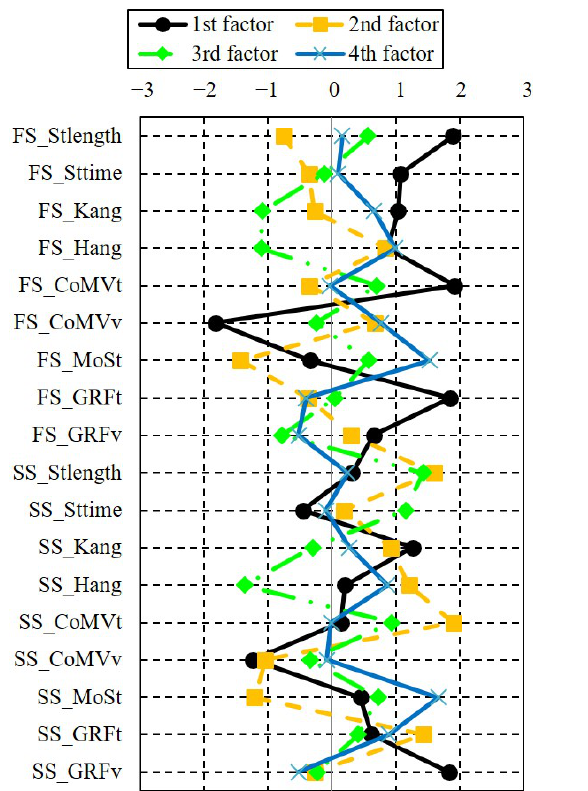
Figure 5. Factor loading. Factor loading vectors of tripping recovery steps at both gait speeds weighted by the contribution of each principal